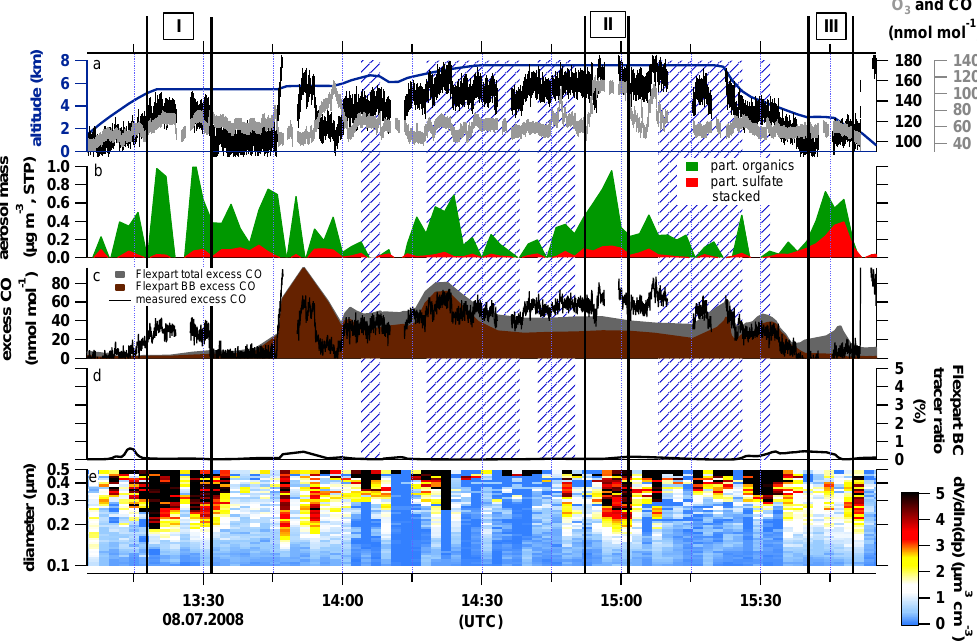
Fig. 3. 8 July, 2008. (a) Aircraft altitude (blue) and trace gas mixing ratios (grey O 3 , black CO) in one second time resolution, the blue striped areas denote relative humidity equal to or greater than 100%. (b) AMS sulphate and organic aerosol mass concentration (stacked) in two minutes time resolution. (c) FLEXPART excess total and biomass burning (BB) CO and measured excess CO (actual concentration minus 100nmolmol − 1 ) , (d) ratio of FLEXPART BC aerosol-like and passive tracer, (e) SMPS volume size distribution at STP. The areas between the black bars with roman numbers indicate the discussed